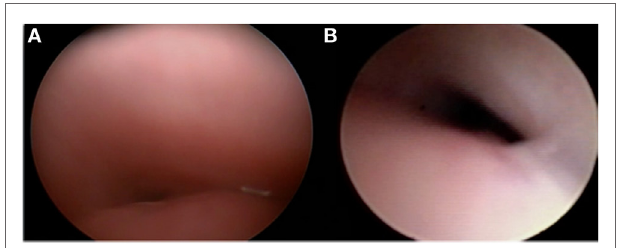
FiGURe 3 | Tracheomalacia before (A) and after aortopexy (b)